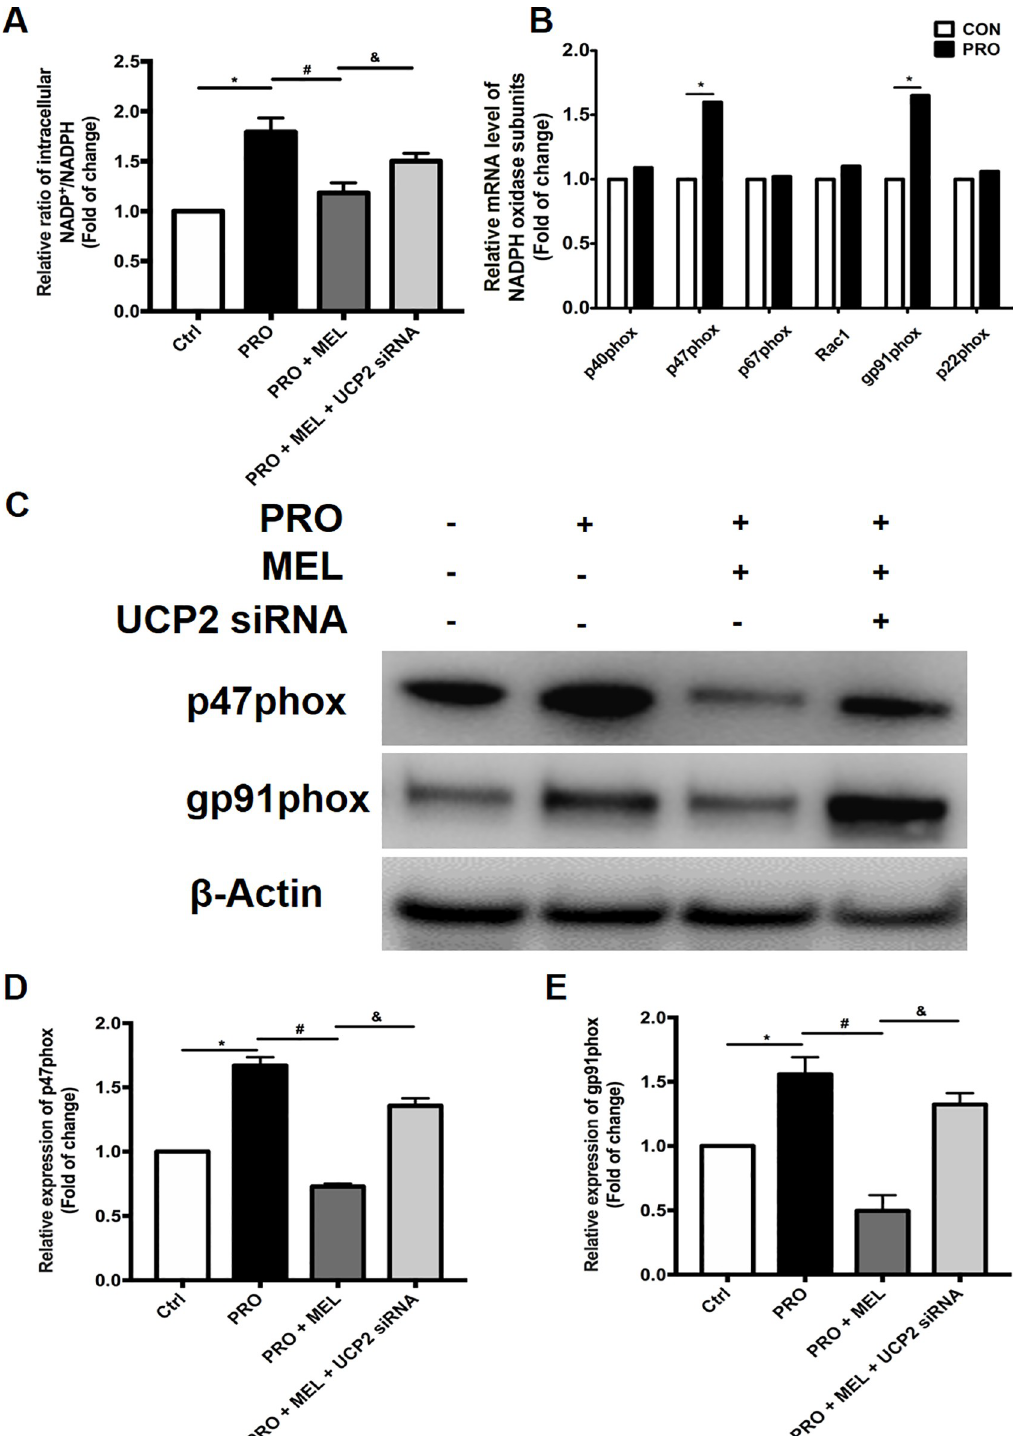
Fig 3. Melatonin decreased NADP + /NADPH Ratio and the expression of p47phox and gp91phox subunit of NADPH oxidase in prorenin-treated microglia. Prorenin increased the NADP + /NADPH Ratio in microglia. Melatonin considerably decreased the redox ratio (NADP + /NADPH) in prorenin-treated microglia. (A) The mRNA level of 6 subunits of NADPH oxidase were measured in different treated groups. (B) The expression levels of p47phox and gp91phox subunit of NADPH oxidase were markedly inhibited in the melatonin treated groups. These effects were reversed by melatonin with UCP2 siRNA